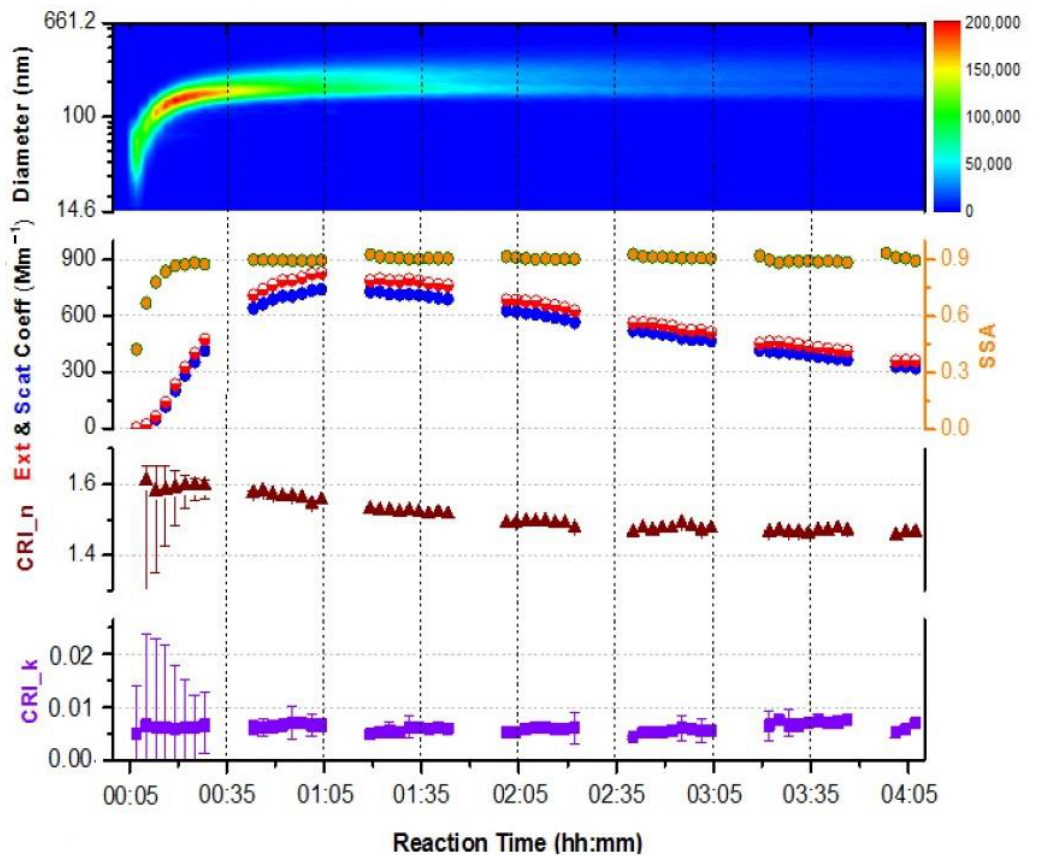
Figure 3. The particle number concentration, mean diameter, extinction and scattering coefficients, SSA and complex refractive index (CRI) of SOA without (NH 4 ) 2 SO 4 seed as a function of reaction time. The SSA and CRI of SOA particles formed in the presence of different concentration of (NH 4 ) 2 SO 4